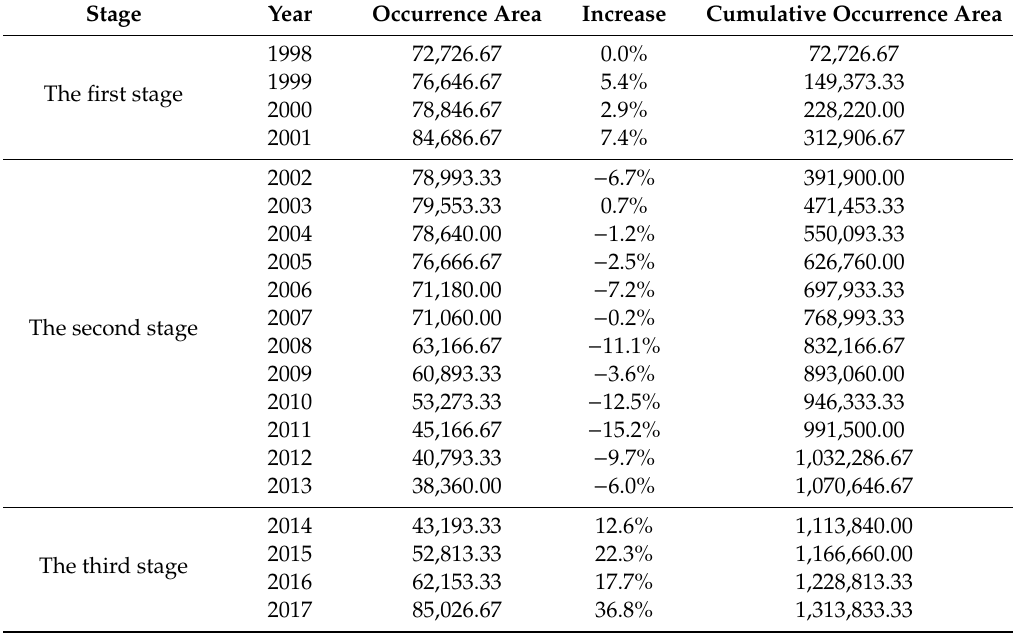
Table A1. Occurrence area of pine wood nematode disease in China from 1998 to 2017 /